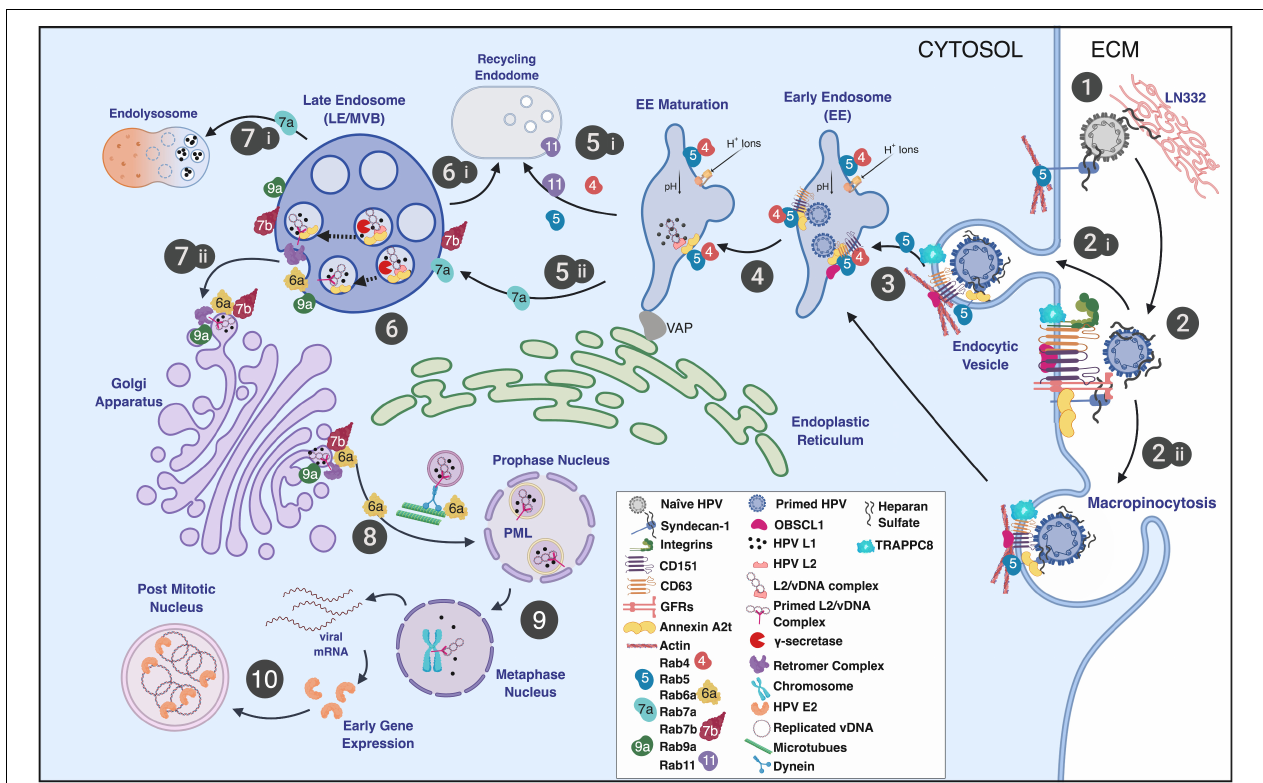
FIGURE 1 | Schematic representation of the HPV infectious entry pathway in keratinocytes noting the involvement of Rab-GTPases in HPV trafficking. (step 1) HPV virions bind the extracellular matrix (ECM), basement membrane, and/or plasma membrane via HSPGs (e.g., syndecan-1) and laminin-332 (LN332). (step 2) Attached virions are conformationally altered by host enzymes, released from the plasma membrane or ECM, and translocate to tetraspanin-enriched microdomains containing a putative uptake receptor complex (e.g., CD151, CD63, integrins, A2t, EGFR, etc.). Viral uptake is thought to occur via (step 2i) receptor-mediated endocytosis, (step 2ii) through a process similar to macropinocytosis, defined as clathrin-, caveolin-, dynamin-, cholesterol-, flotillin-, and lipid raft-independent. (step 3) Entry is facilitated by actin polymerization and remodeling with the involvement of CD151, CD63, adaptor proteins (e.g., OBSCL1 and syntenin-1), A2t, and TRAPPC8 leading to virion localization to EE. (step 4) Viral localization to EE is thought to be CD63 and Rab5 dependent and is coupled to the acidification of the EE. (step 5) Endosomal tubulation ensues with the formation of an ER contact via the VAP complex. EE acidification results in capsid dissociation, releasing the viral genome in a complex with L2. EE have multiple fates and can either mature into recycling endosomes (step 5i) or LE/MVB (step 5ii). Endosomal maturation is linked to Rab function and is defined by Rab conversion (step 5i,5ii; see the text for details). (step 6) Intraluminal L2 is cleaved by γ -secretase exposing the L2 cell-penetrating peptide (CPP) and a transmembrane domain. MVB sorting mechanisms give rise to recycling endosomes, which are not known to be involved in HPV intracellular trafficking (step 6i). (step 7i) L2 membrane penetration and exposure of the cytosolic domain of L2 leads to the recruitment of the retromer complex. Retromer and Rabs 6a, 7b, and 9a participate in trafficking of the L2/vDNA complex to the TGN. (step 7ii) A portion of L1 protein is trafficked to the lysosome for degradation. (step 8) L2-containing vesicles derived from the Golgi interact with microtubules via exposed L2 domains facilitating Rab6a-dependent vDNA